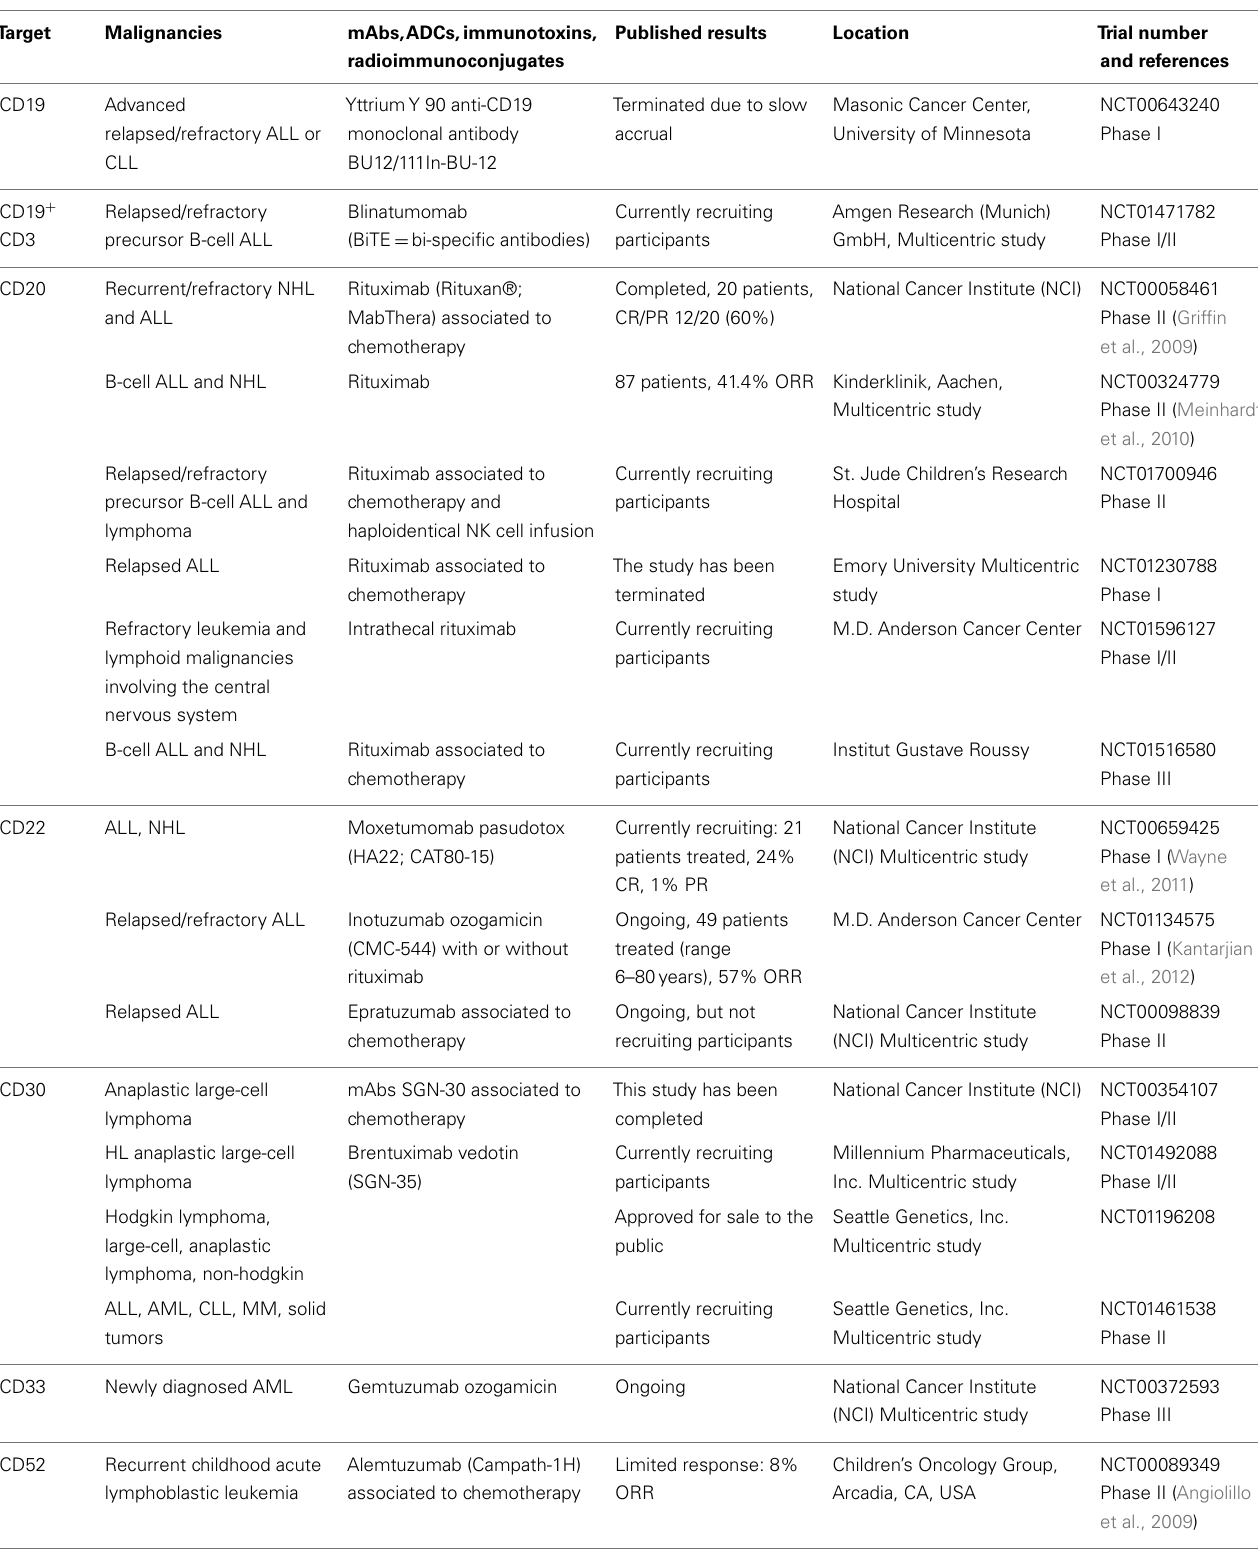
Table 1 |The list represents a selection of the main trials for each single agent for novel approaches in pediatric hematological malignancies in the field of mAbs and